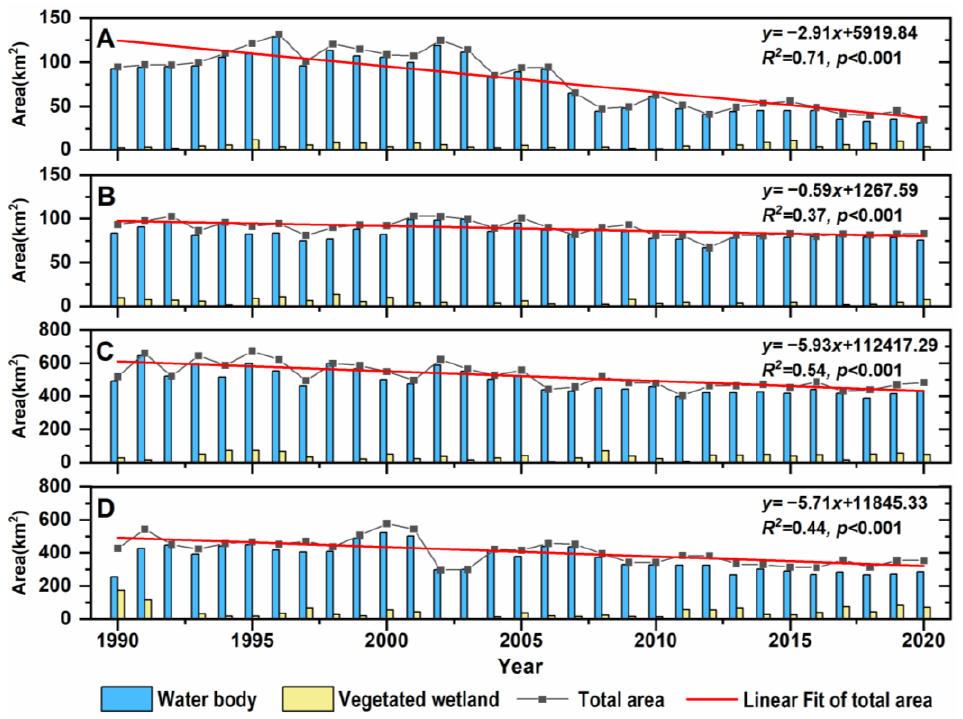
Figure 11. Area changes of urban wetlands from 1990 to 2020. ( A–D ) present the area changes of urban wetlands in four study sites (Site(A – D)) between 1990 and 2020, respectively.